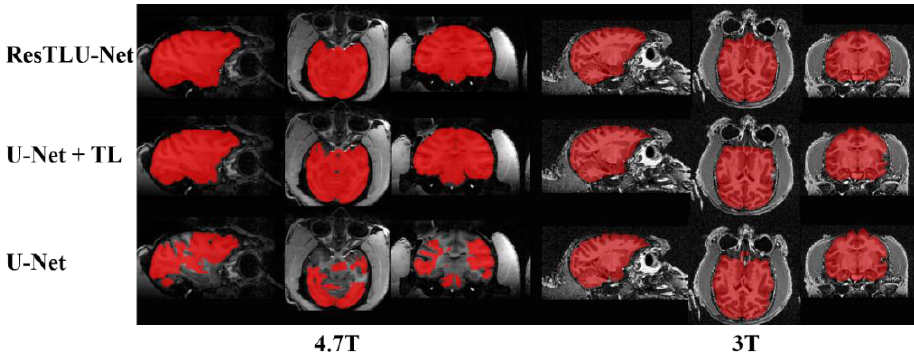
Figure 12. Examples of brain extraction results, using different brain extraction models.